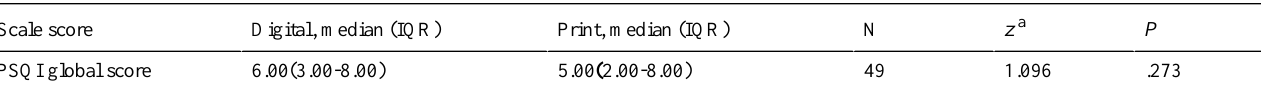
Table 4. Scale scores for digital and print